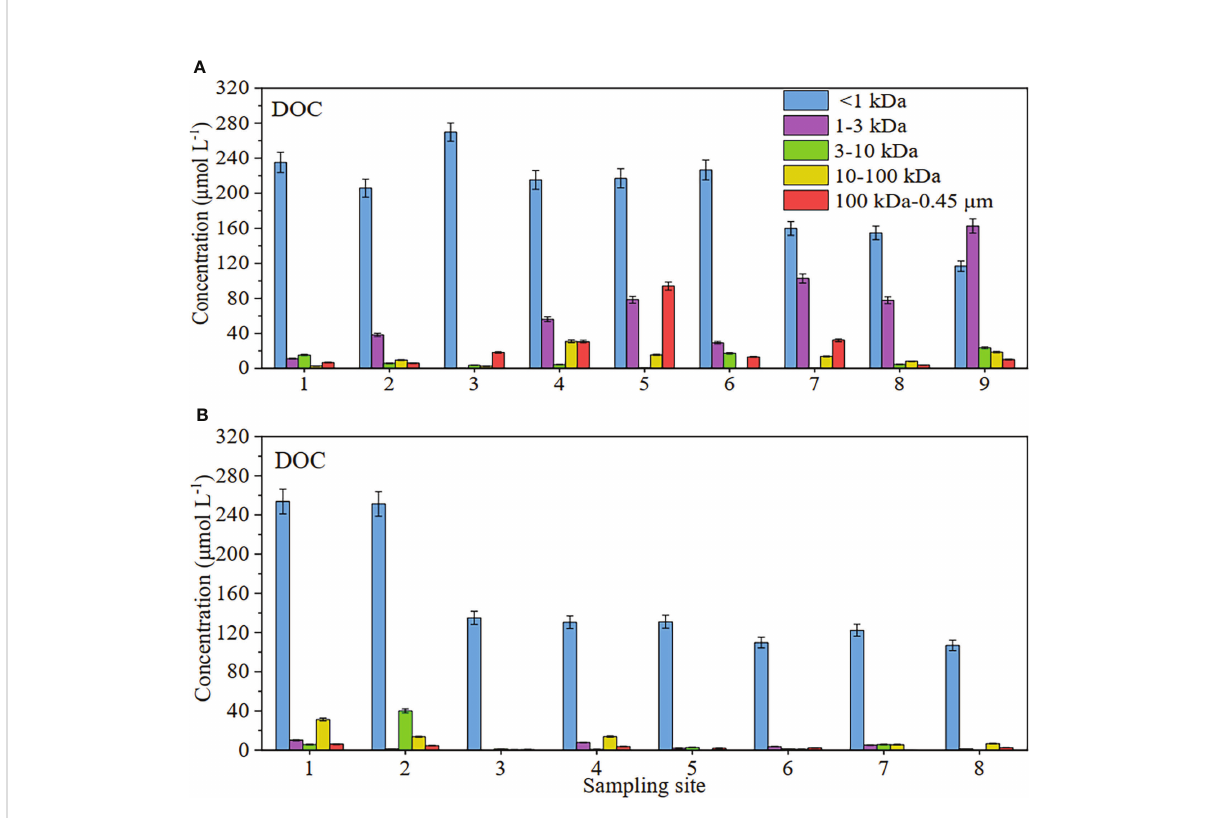
FIGURE 2 Concentration distribution of DOC at different sites in surface waters of the Yellow River Estuary in spring (A) and autumn (B)